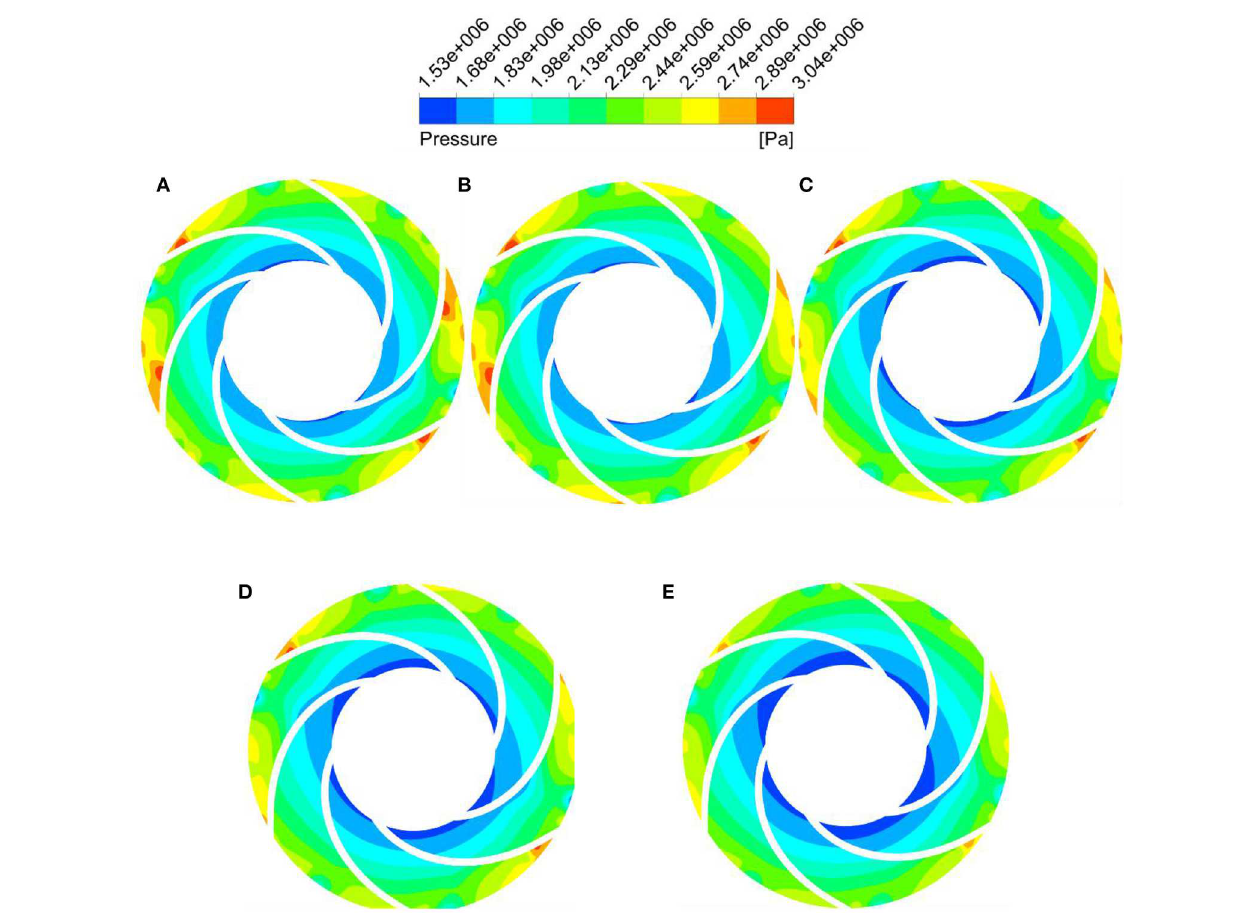
FIGURE 18 | Static state distribution of the second stage impeller in the start-up process of the open-valve transition. (A) t = 0.93s, (B) t = 1.36s, (C) t = 1.83s, (D) t = 2.35s, and (F) t =